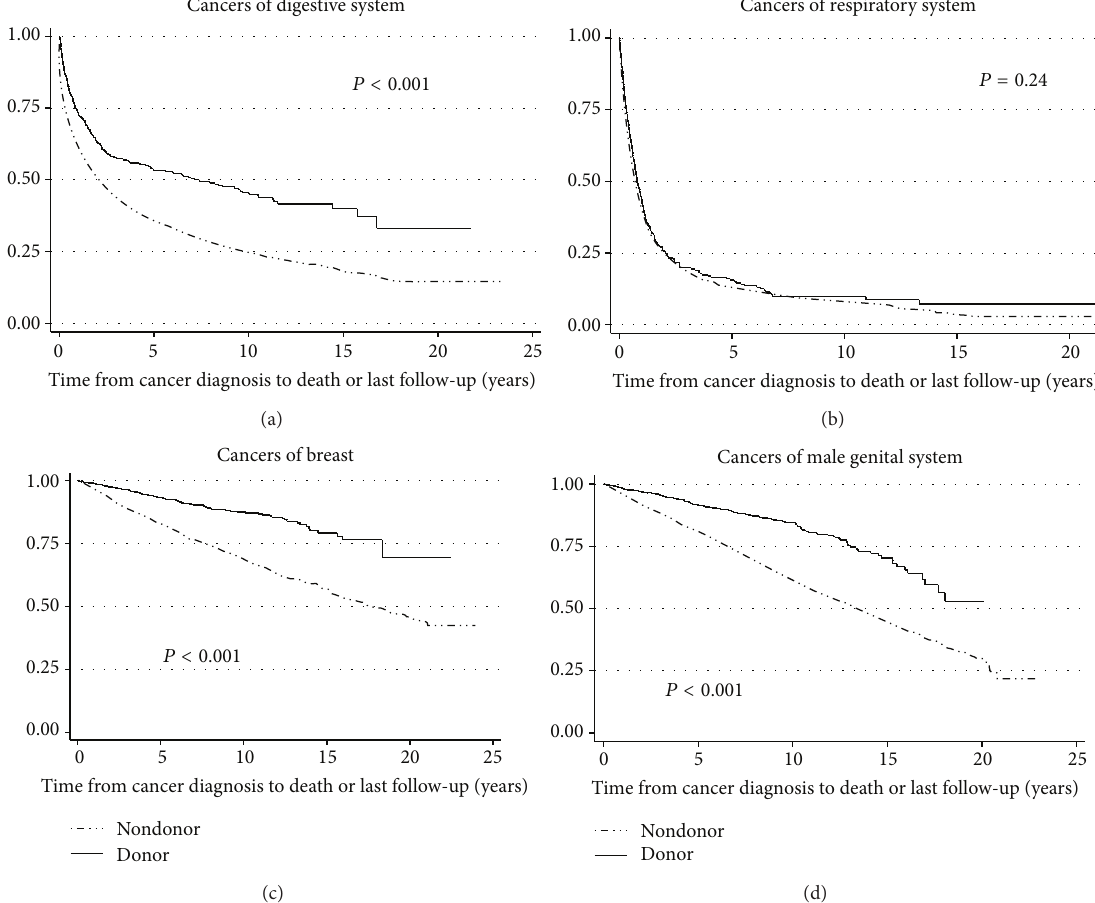
Figure 3: KM survival curves for all-cause mortality for donors and nondonors with (a) cancers of digestive system ( 𝑃 = 0.24 ); (b) cancers of respiratory system ( 𝑃 < 0.001 ); (c) breast cancers ( 𝑃 < 0.001 ); (d) cancers of male genital system ( 𝑃 < 0.001 ); 𝑥 -axis represents survival time in